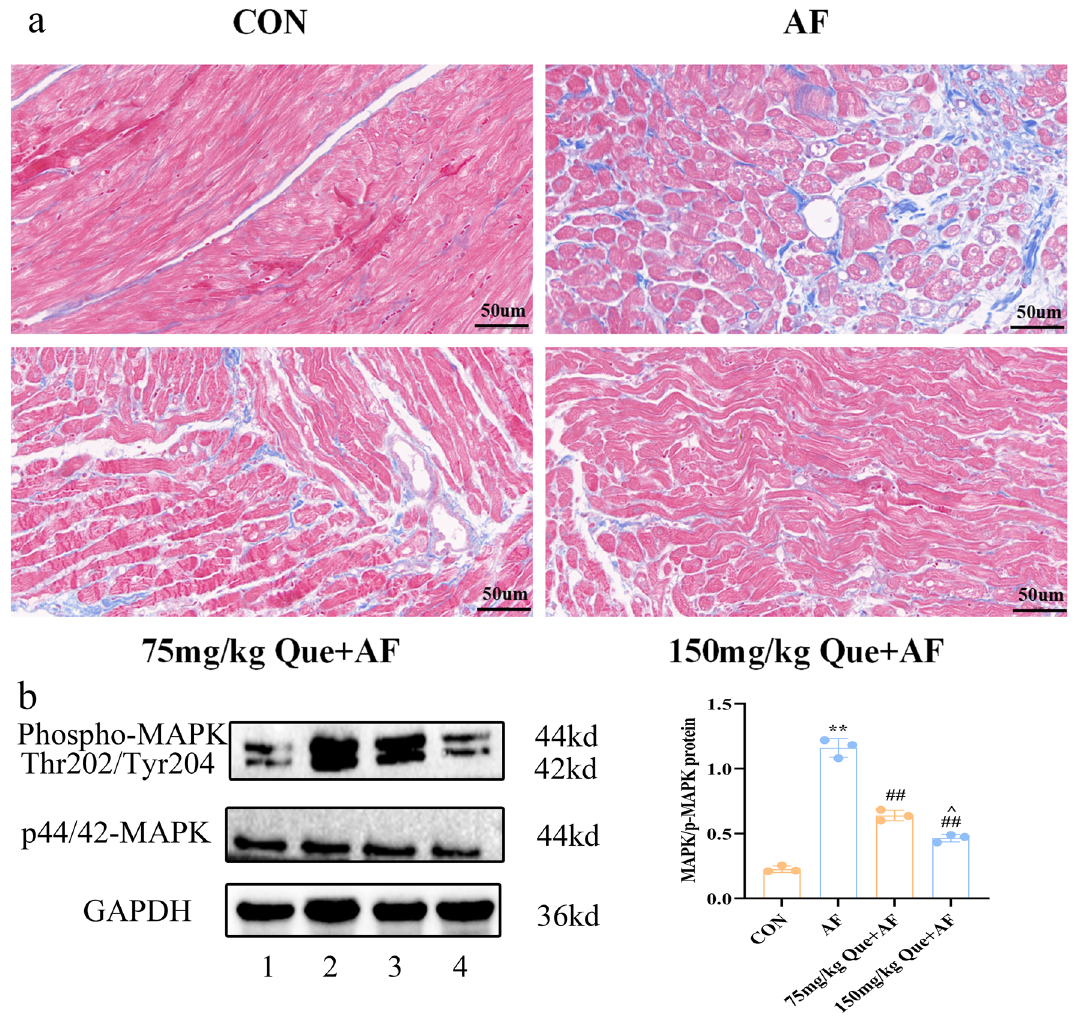
Figure 11. ( a ) Changes in atrial muscle fibrosis in each group. ( b ) Differences in MAPK and P-MAPK protein expression in each group. 1: CON, 2: AF, 3: 75 mg/kg Que + AF, 4: 150 mg/kg Que + AF. **P < 0.01 VS CON; # P < 0.05 VS AF, ## P < 0.01 VS AF; ^ P < 0.05 VS 75 mg/kg Que +